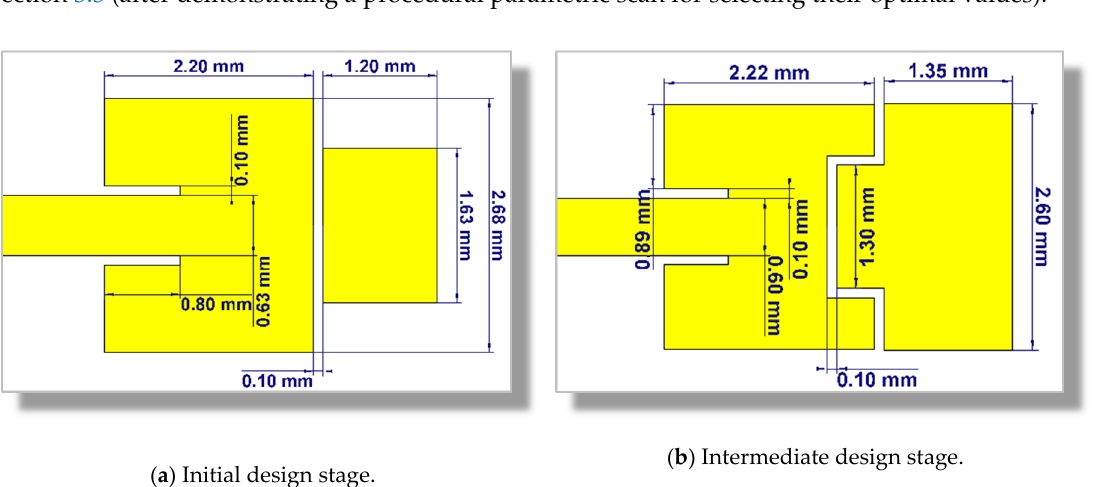
Figure 5. Simulated surface current, tangential magnetic field distributions, and the corresponding radiation patterns of the proposed dual-band patch antenna at 38.24 GHz and 59.56 GHz .